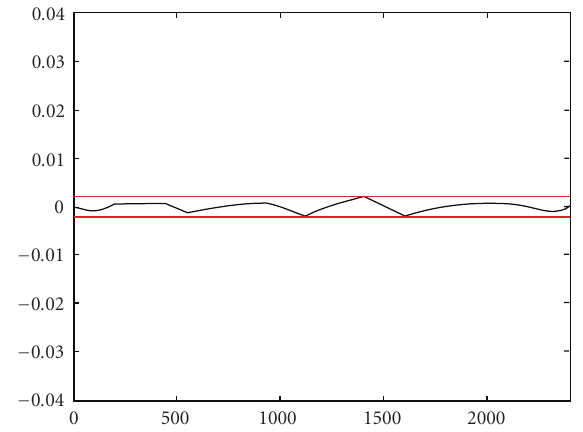
Figure 10: The values of the global acceleration constraint for the result shown in Figure 6(d). The horizontal lines give the limits of the acceleration